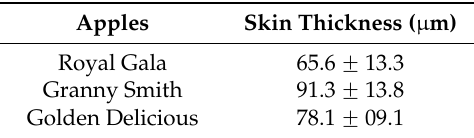
Table 1. Apple skin thickness measured with a confocal microscope.